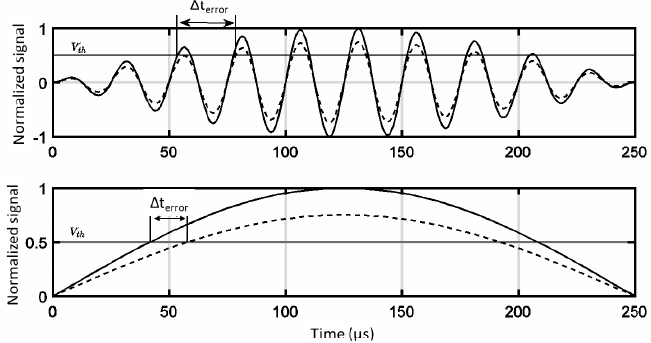
Figure 3. Effect of the received power on the estimation of the travelling time for the ultrasound signal.